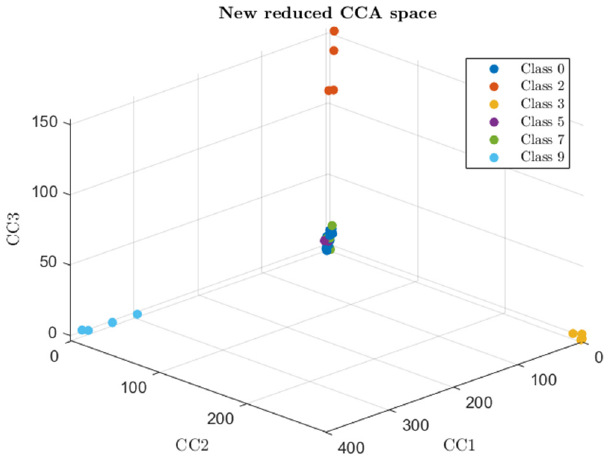
Figure 8. Data arrangement with respect to three of the reduced dimensions by CCA (the reference class is the health one, outliers were removed and the vectors were orthogonalized).